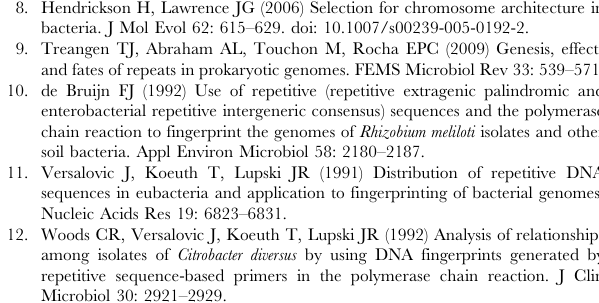
Figure S4 Alignments of the most abundant sequence groups in SBW25. GI sequences are shown in ( A ), GII sequences in ( B ) and GIII sequences in ( C ). The consensus sequence contains the respective palindromic cores (framed in red). Numbers to the left of the alignment denote the frequency of the respective 16-mer (e.g. the first 16-mer in ( A ) GGGCTTGCTCCCGATG occurs 57 times). Colored nucleotides within the alignment denote differ- ences to the consensus sequence. Figure S5 Process of REP sequence cluster determination. REP sequences are blue boxes. Red arrows indicate a sequence length of 400 bp. The algorithm starts with the position of the first REP sequence (a) and adds it to cluster 1. It then checks the distance to the next REP sequence. The distance to REP sequence (b) is less than 400 bp, hence, the size of cluster 1 increases by one. The distance from (b) to the next REP sequence (c) is greater than 400 bp, therefore, the final size of cluster 1 is two and a new cluster of size one is created called cluster 2. The distance from REP sequence (c) to the next REP sequence is greater than 400 bp; hence, cluster 2 is closed. Figure S6 Excision events detected in Illumina sequencing data. ( A ) Shows fastq formatted raw Illumina sequences for the excision events and their corresponding paired ends or ‘mates’. Quality scores are the last line of each fastq entry. ( B ) In all cases Read 1 matches to a position close to the corresponding Read 2 as expected for paired end reads. The alignments show the match between the sequence reads (second line in the alignment) and the SBW25 genome (first line in the alignment). Colored nucleotides show differences between genome and sequence read. Secondary structure predictions of the excised sequences are shown on the right. For the fourth excision a total of 200 sequence reads were found showing the same event, indicating that the entire REPIN was excised from the genome. Figure S7 Schematic representation of a typical tandemly repeated REPIN cluster. The cluster comprises two tandem repeat units. Each unit consists of a 5 9 flanking sequence (f1) followed by a REPIN and ends with a second shorter flanking sequence (f2). The two units are usually separated by a short stretch of DNA that is not repeated. Figure S8 Approximate positions of the tandem repeat clusters in the genome of SBW25. The tandem repeats are formed by sequences from GI and GIII. The gray and black arrows indicate different module lengths.